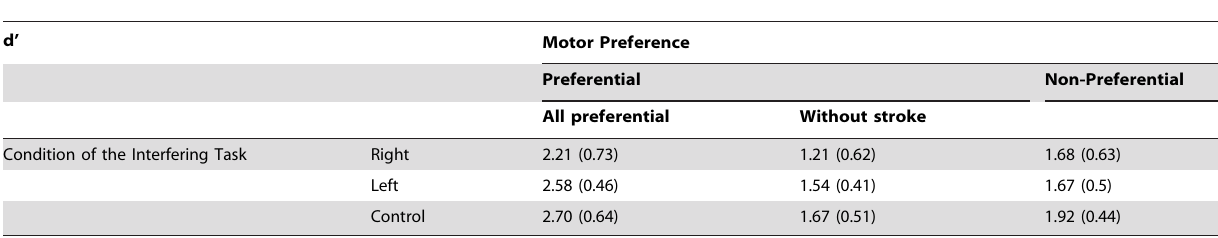
Table 1. discrimination sensitivity